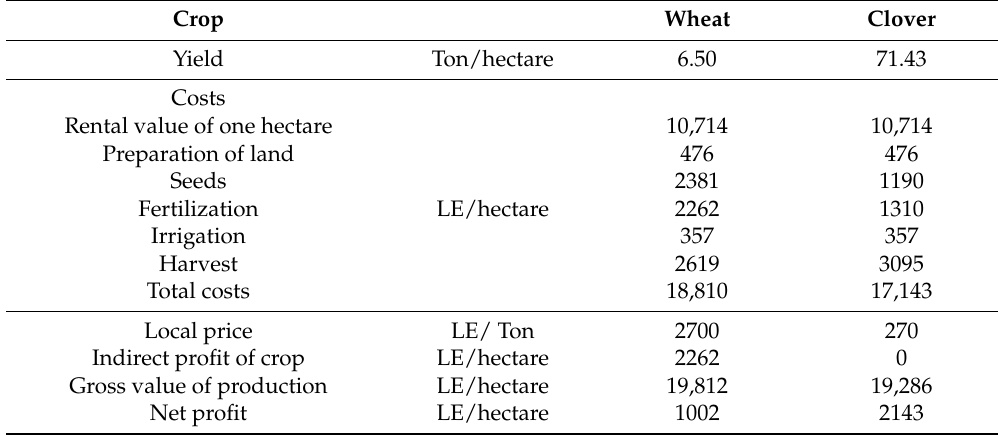
Table 6. Economic analysis of crops in the Al-Qased command area during the winter season (from November 2015 to May 2016).